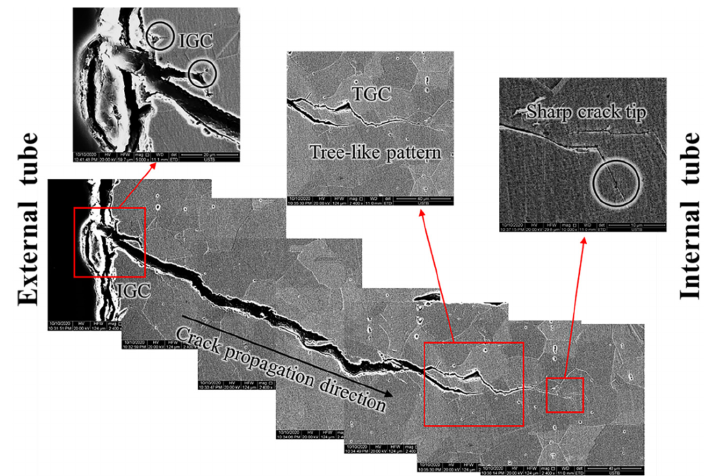
Figure 9. The cross-sectional morphology of a crack.